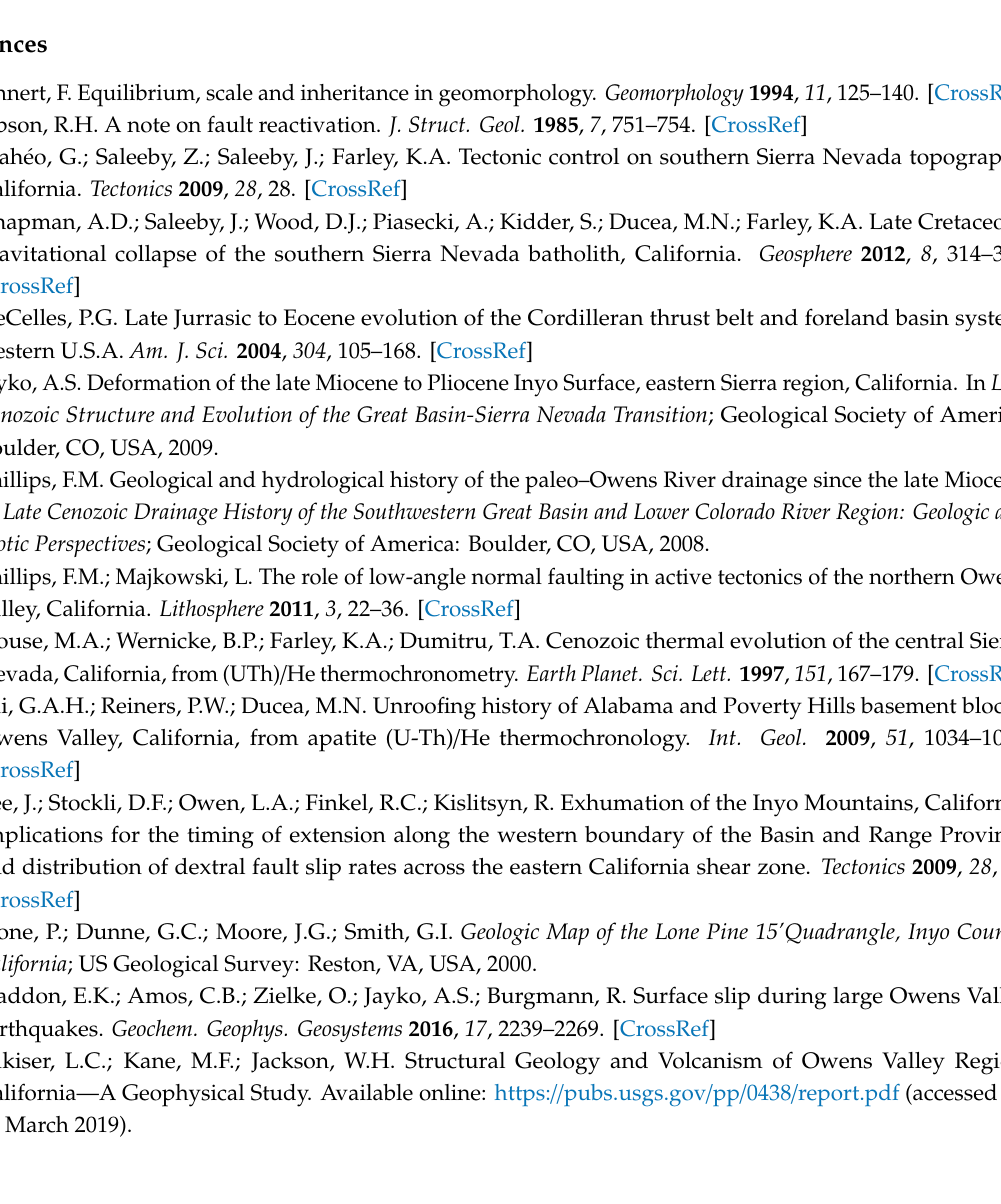
Table S1: Single-grain apatite and zircon data for Inyo Mountains transect. Figure S1: Summary model predictions of expected model results for Inyo Mountains transect. Figure S2: Raw QTQt expected model output for Inyo Mountains transect. Figure S3: Summary model predictions of expected model results for Mount Whitney transect. Figure S4: Raw QTQt expected model output for Mount Whitney transect. Tables S2–S7: QTQt input data file text for six samples of the Mount Whitney transect. Tables S8–S14: QTQt input data file text for seven samples of the Inyo Mountains transect. Table S15: maximally muted elevations used for model inputs expressed in Figures S5–S7. Figure S5: QTQt expected model output for maximally muted elevations, clipped to same extent as the main paper in Figure 4. Figure S6: Summary model predictions of expected model results for Inyo Mountains transect using maximally muted elevations. Figure S7: Raw QTQt expected model output for Inyo Mountains transect using maximally muted